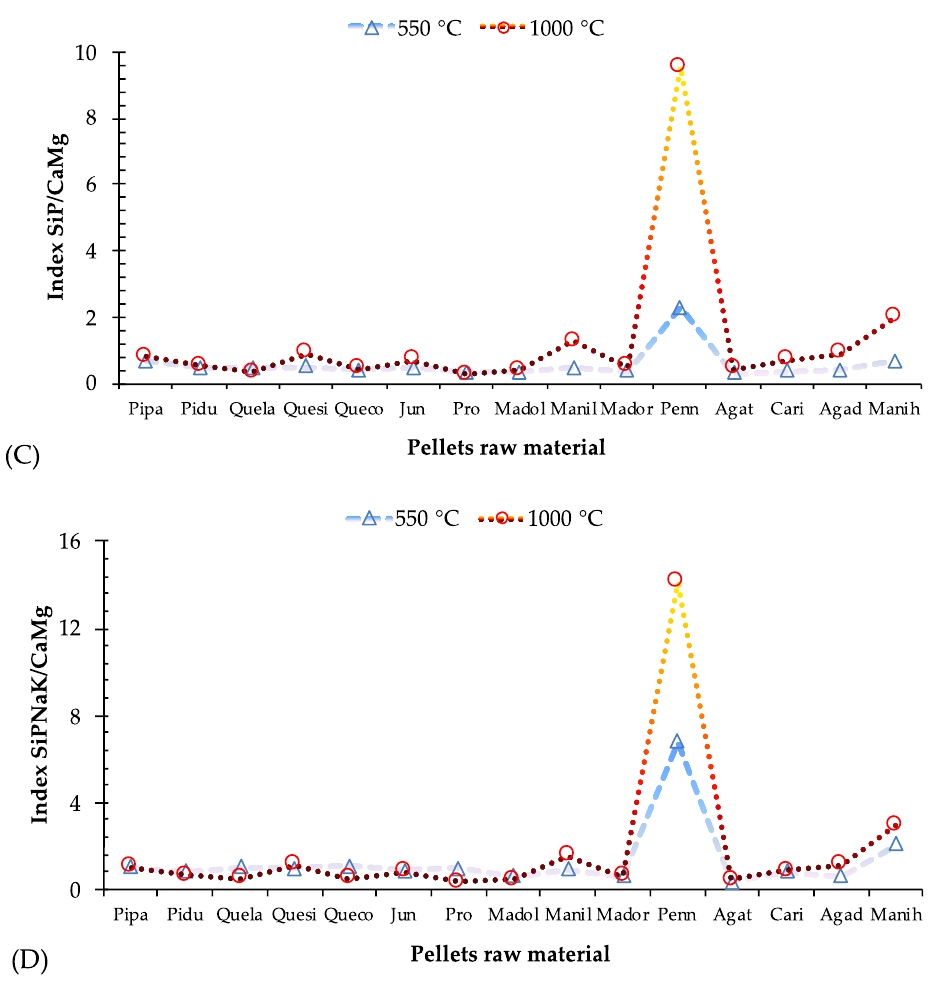
Figure 6. Slag indexes from 15 pelletized biomass sources calcined at 550 ◦ C and 1000 ◦ C temperatures. ( A ) Index NaK/B, ( B ) Index B, ( C ) Index SiP/CaMg and ( D ) SiPNaK/CaMg.